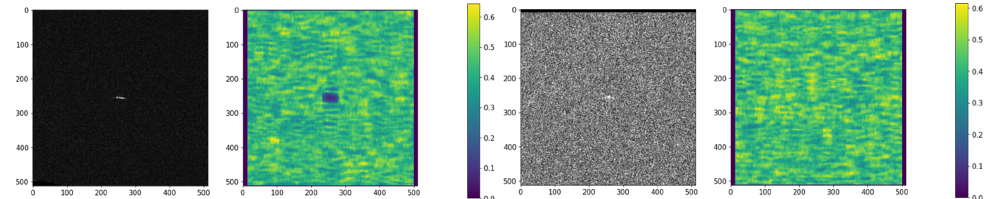
Figure 7. Example of IE calculated for ship target ( left ) and ambiguity ( right ) for a Sentinel-1 product.